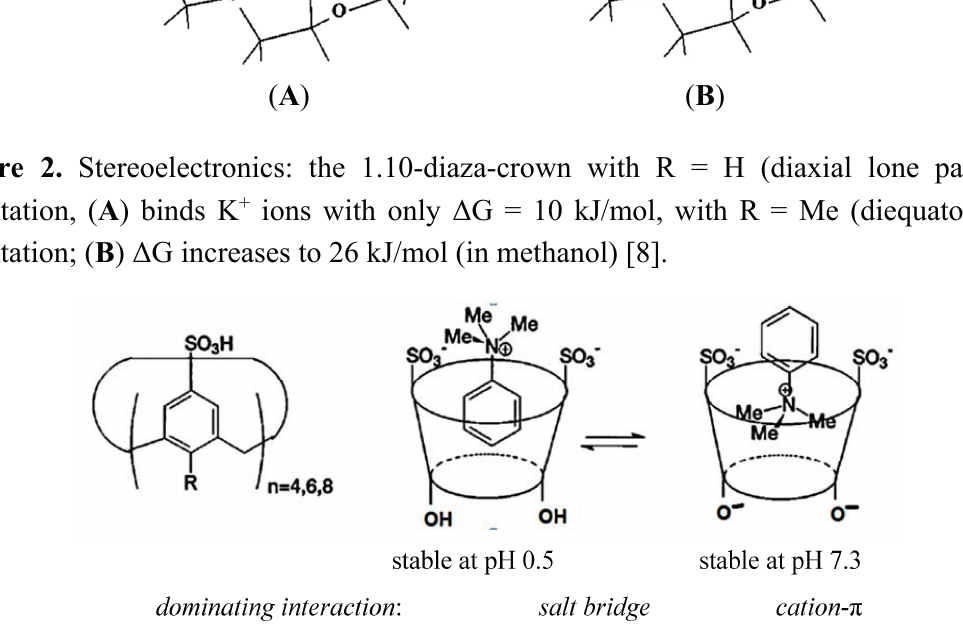
Figure 3. Change of inclusion mode with a calix[4]arene host ( n = 4) as function of the pH